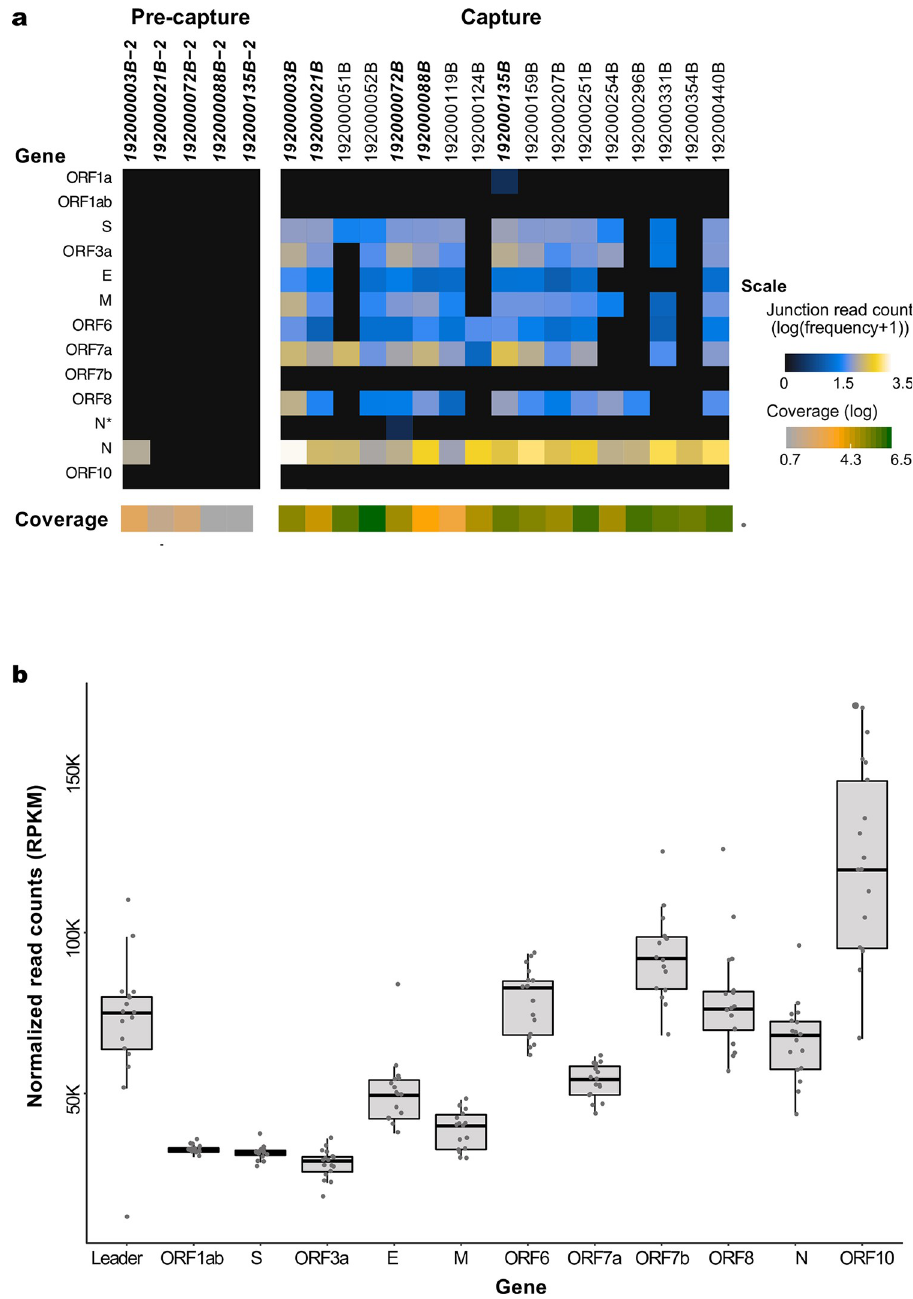
Fig 5. SARS-CoV-2 subgenomic mRNAs. (a) Junction read quantification per gene (log transformed), estimated using one million reads/sample from five pre-capture and 17 capture samples. Samples chosen for this analysis have above 95% genome completeness. The coverage level per sample is shown below the gene heatmap. Samples in bold denote same sample sequenced as pre-capture and capture. ( b ) ORF read coverage shown as normalized read counts (RPKM) per gene for 17 capture samples. The boxes represent the first quartile to the third quartile of the normalized read counts for each ORF. The horizontal lines in the boxes represent the median values, and the whiskers represent the variability outside the lower and upper